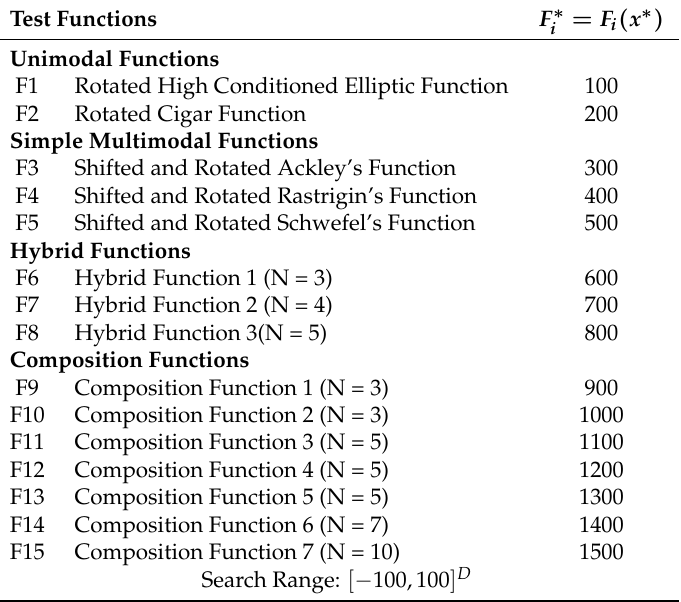
Table 1. Summary of the Congress on Evolutionary Computation (CEC)’15 Benchmark functions used in our experimental